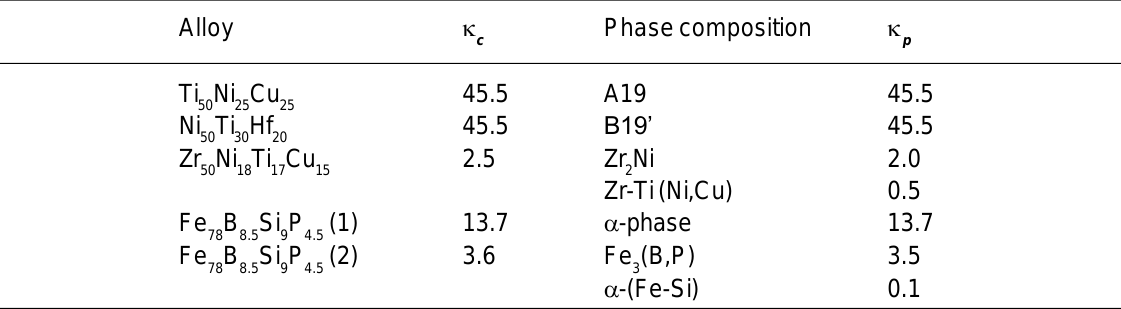
and  for the studied c p